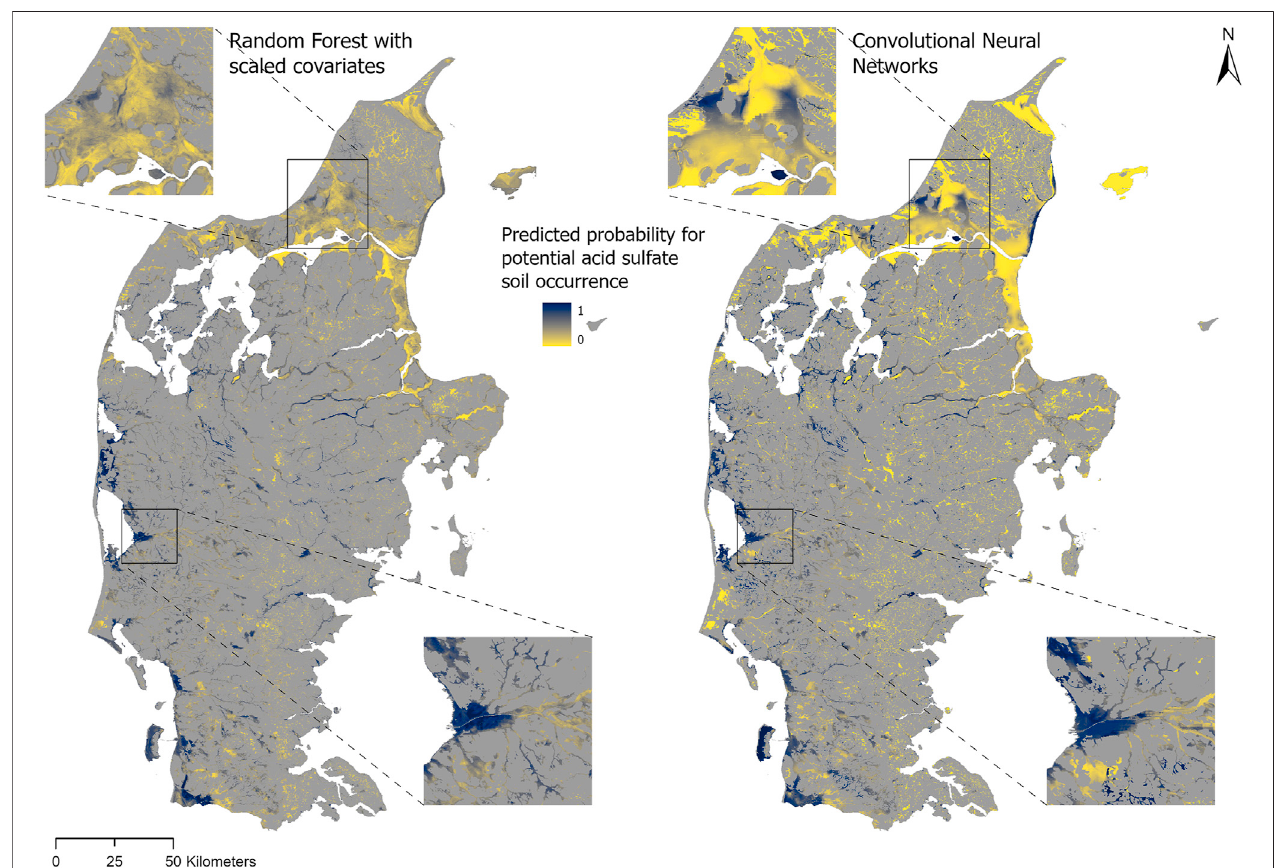
FIGURE 3 | Maps of the predicted probability for potential acid sulfate soil occurrence generated using Random Forest (RF) with scaled covariates (left) and Convolutional Neural Networks (CNN; right).